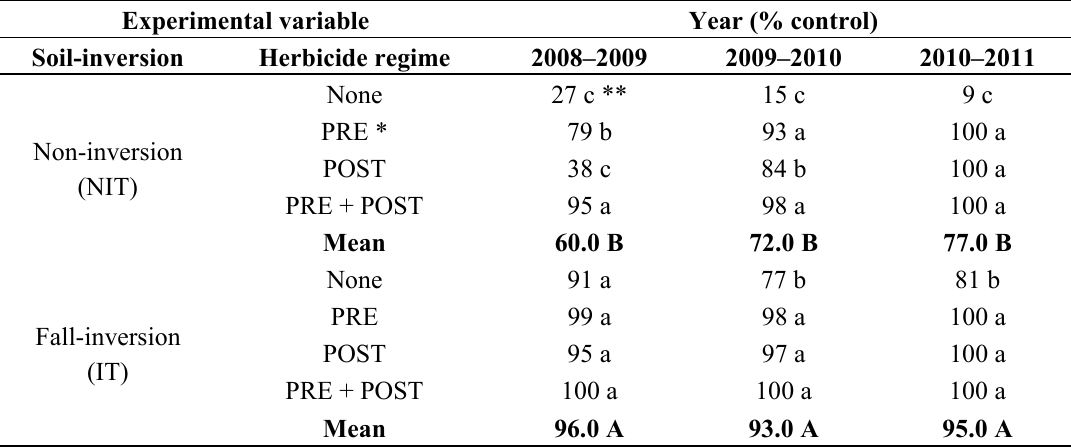
Table 5. Influence of soil-inversion by herbicide regime on Palmer amaranth control at 6 WAP * with cover crop data combined in three production